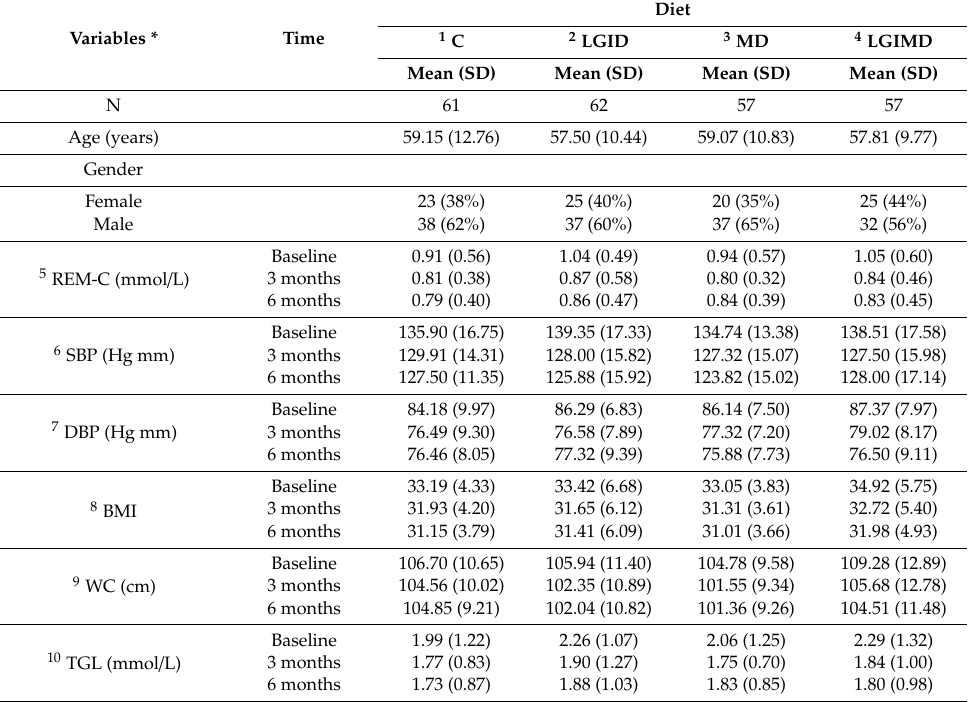
Table 1. Descriptive statistics (mean ( ± standard deviation) or relative frequency (%)) of the main characteristics of the participants by intervention and